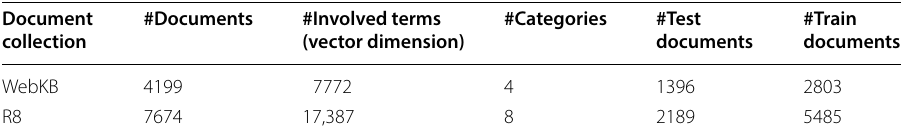
Table 3 Properties of real-world document collections Document